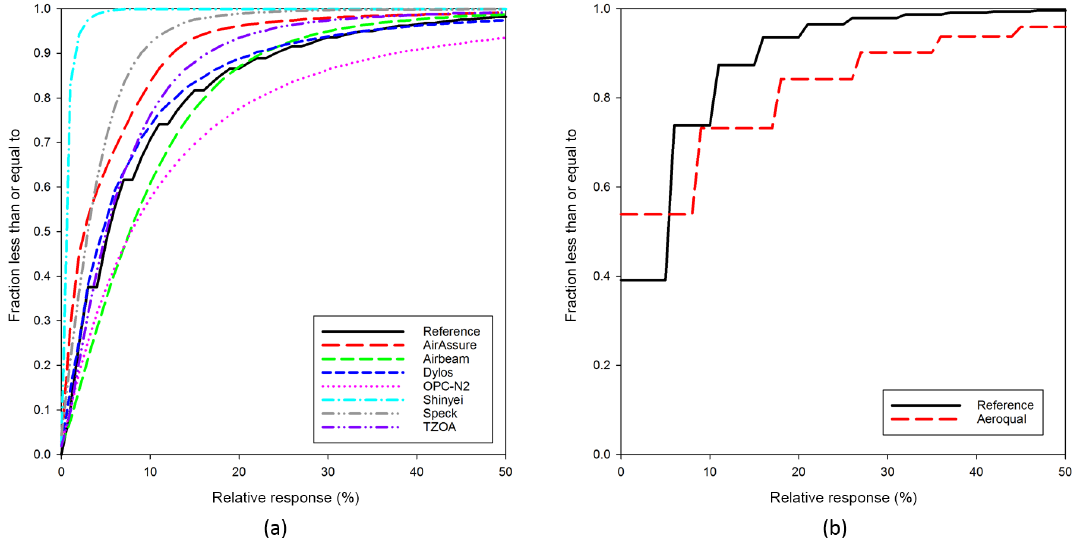
Figure 6. Cumulative distribution functions for 1min response differences for (a) PM 2 . 5 and (b) O 3 sensor and reference